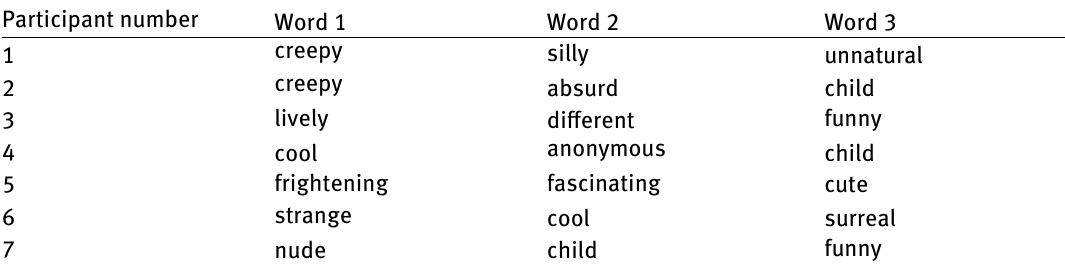
Table 2: 3-word entries of interviewed